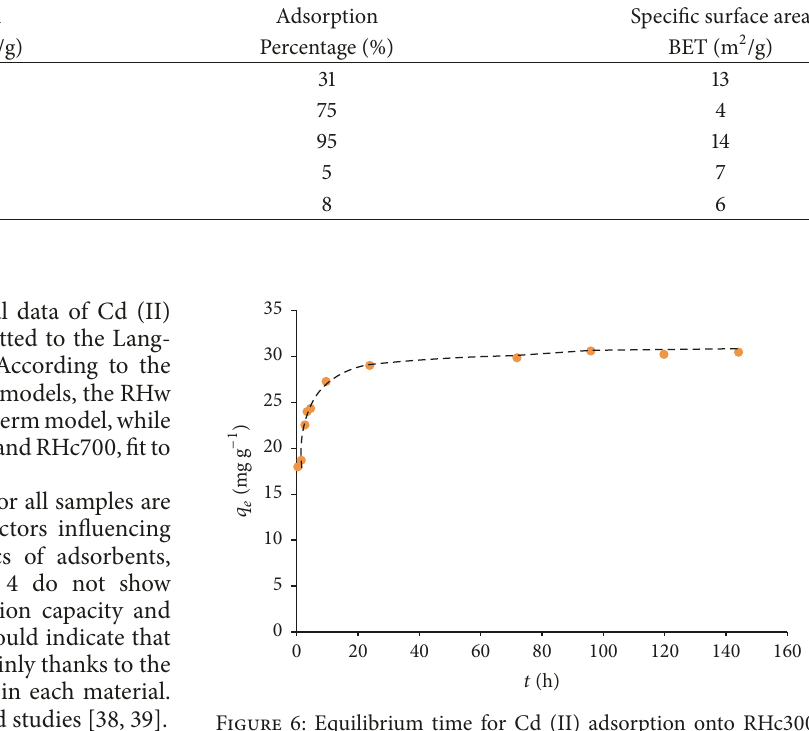
Figure 6: Equilibrium time for Cd (II) adsorption onto RHc300 sample at pH = 6. Dashed line only shows data